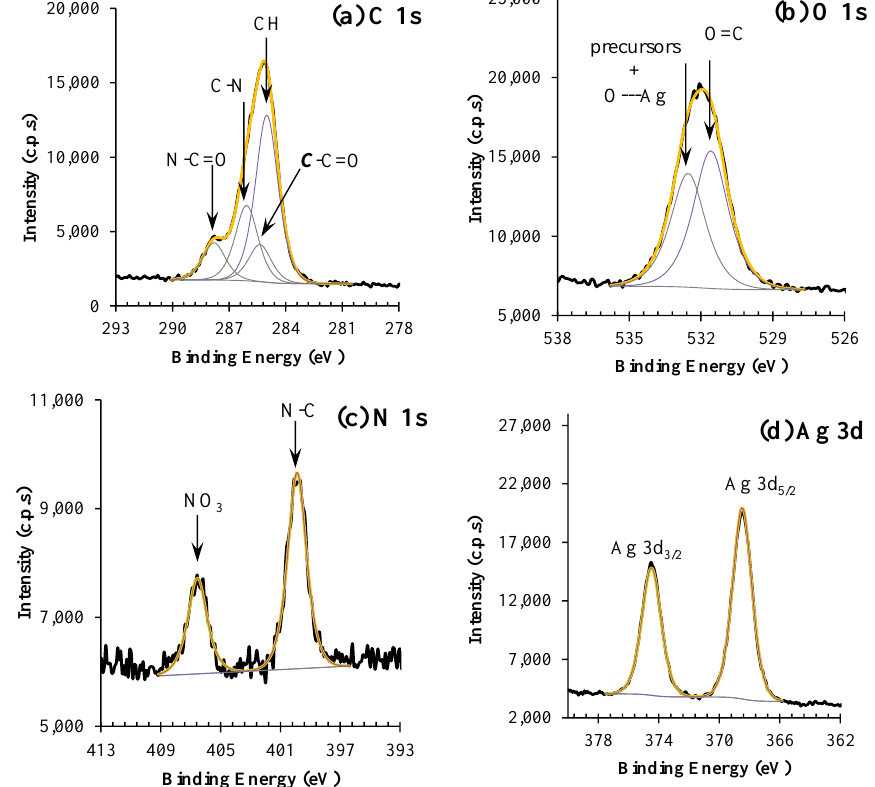
Figure 2. XPS regions of ( a ) C 1s, ( b ) O 1s, ( c ) N 1s, and ( d ) Ag 3d for silver nanoparticle dispersions (AgNP). Four peaks centered at 285.0, 285.4, 286.1, and 287.8 eV, typical of PVP, were fitted into the C 1s envelope. The detailed assignment is presented in Figure 3.